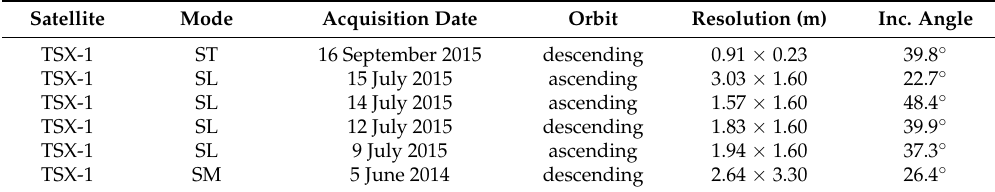
Table 1. TSX images used in the experiment, with resolution given as ground-range resolution by azimuth resolution and incidence angle (Inc. angle) at the scene center (ST = staring spotlight mode, SL = spotlight mode, SM = stripmap mode).